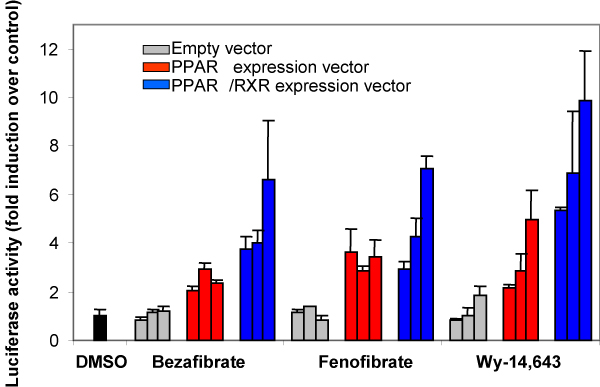
Activation of PPARα by three PPARα agonists. Primary hepatocytes were co-transfected with a luciferase reporter construct containing PPRE and with or without PPARα/RXR expression vectors. Twelve hours after transfection, three PPARα agonists, bezafibrate, fenofibrate and WY-14,643 were added at the concentrations as indicated. Cells were harvested after 24 h drug treatment. Luciferase activity was normalized against β-galactosidase activity. The groups having three bars indicate different treatments with the concentrations of 10, 30 and 100 μM, from left to right. Error bars represent standard derivations of two replicates.